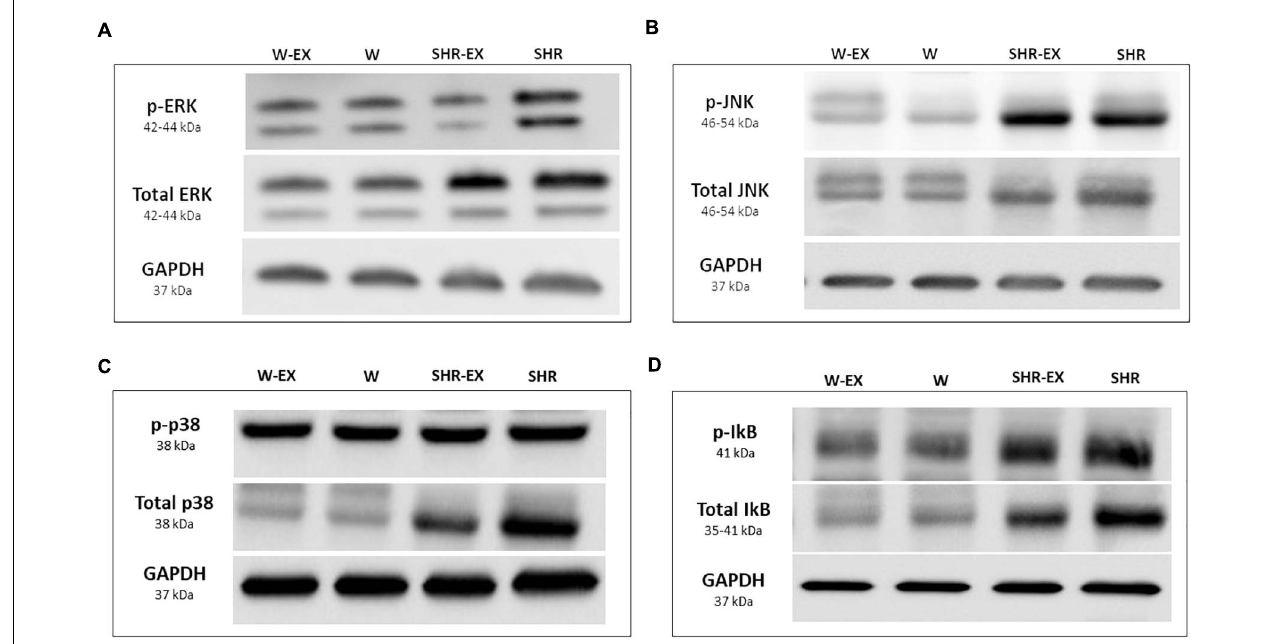
FIGURE 3 | Representative Western blots. W, Wistar rats; W-EX, exercised Wistar rats; SHR, spontaneously hypertensive rats; SHR-EX, exercised SHR; (A) ERK, extracellular-signal-regulated kinase; (B) JNK, Jun N-terminal kinase; (C) p-38; (D) I κ B, inhibitor of nuclear factor kappa B.